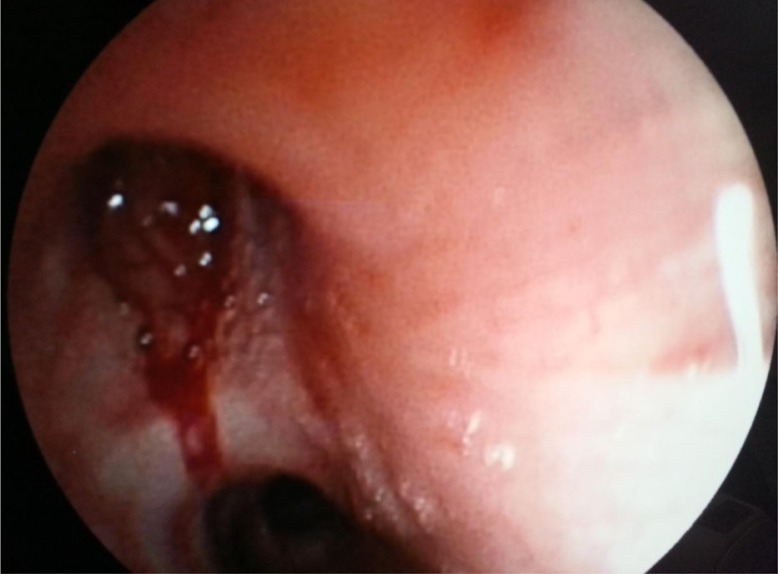
Bronchoscopic view.